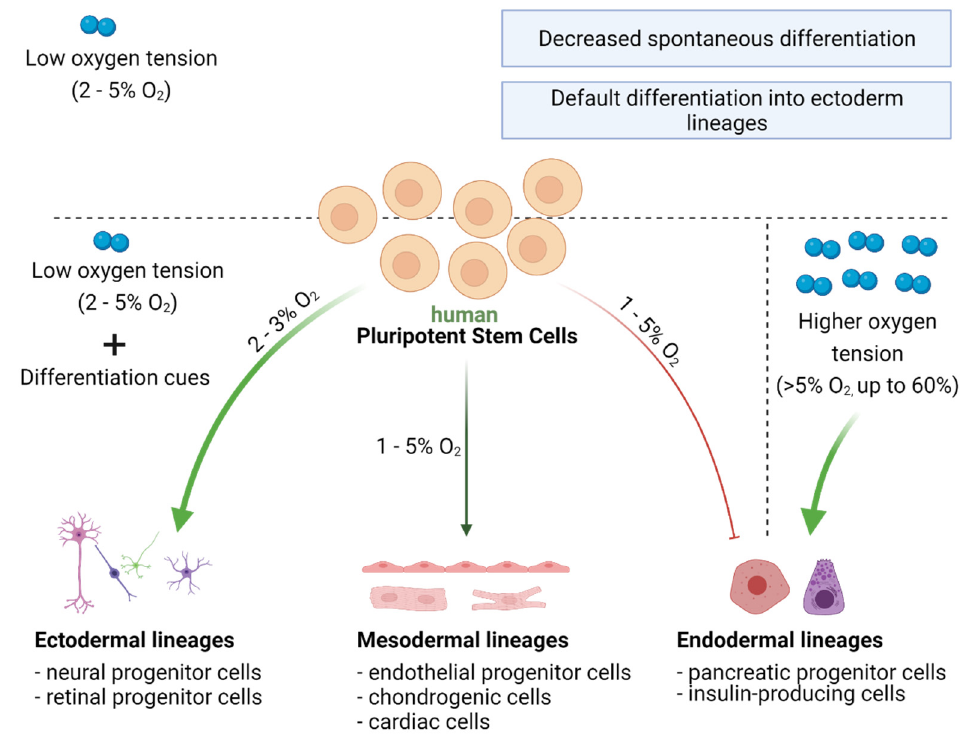
Figure 5. Impact of oxygen on the differentiation of hPSCs. hPSCs can differentiate into cells of three germ layers: ectoderm, mesoderm, and endoderm. Oxygen concentration influences the differentiation capacity of hPSCs. Low oxygen tension alone decreases spontaneous differentiation of hPSCs; however, in combination with differentiation cues, hypoxia facilitates differentiation into endodermal and mesodermal lineages. Conversely, differentiation of hPSCs into endodermal lineages decreases with low oxygen tension and increases under high oxygen concentrations (up to 60%).